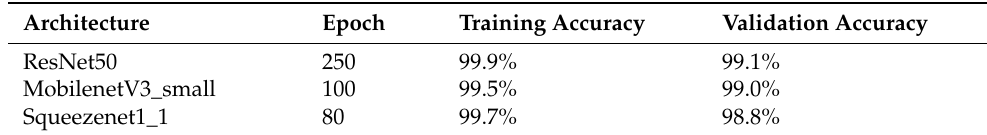
Figure 4. Losses during training: ( a ) ResNet50, ( b ) MobileNetV3-Small, and ( c ) SqueezeNet 1_1. Table 2. Performance of the three models.